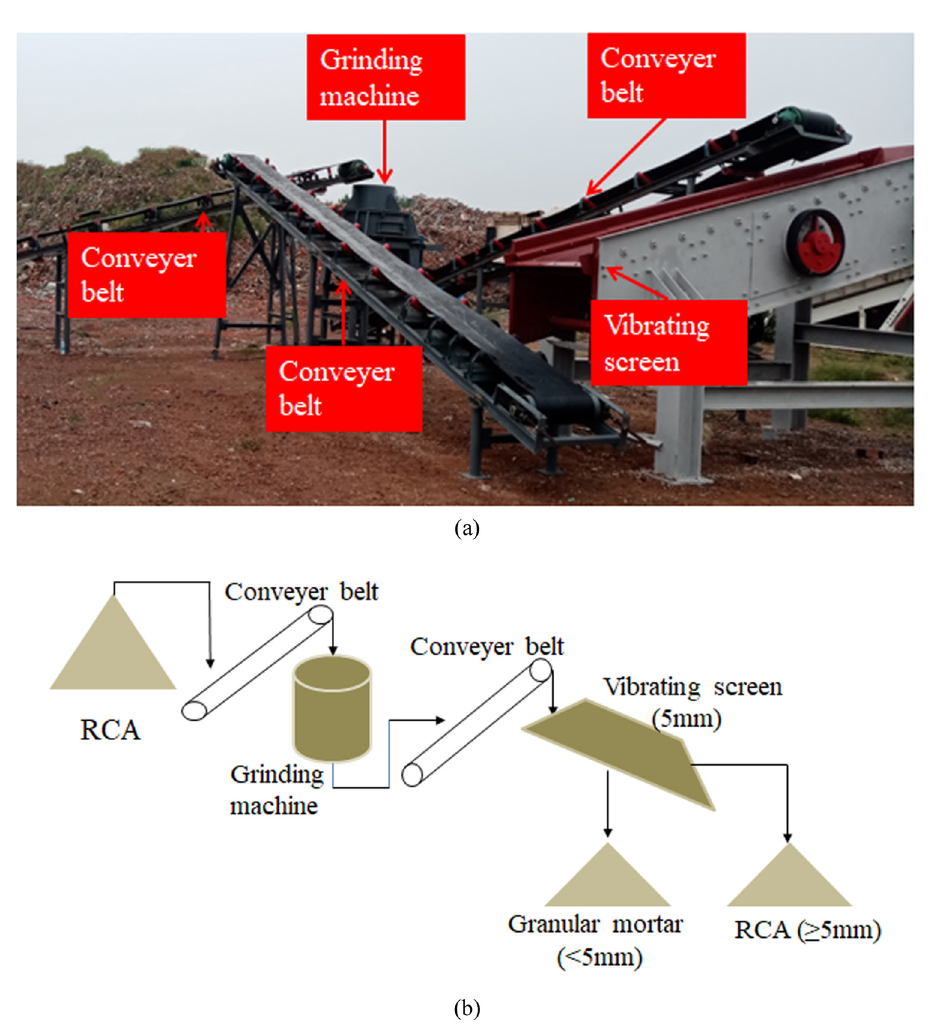
Figure 2: ( a ) RCA slurry removal equipment and ( b ) work fl